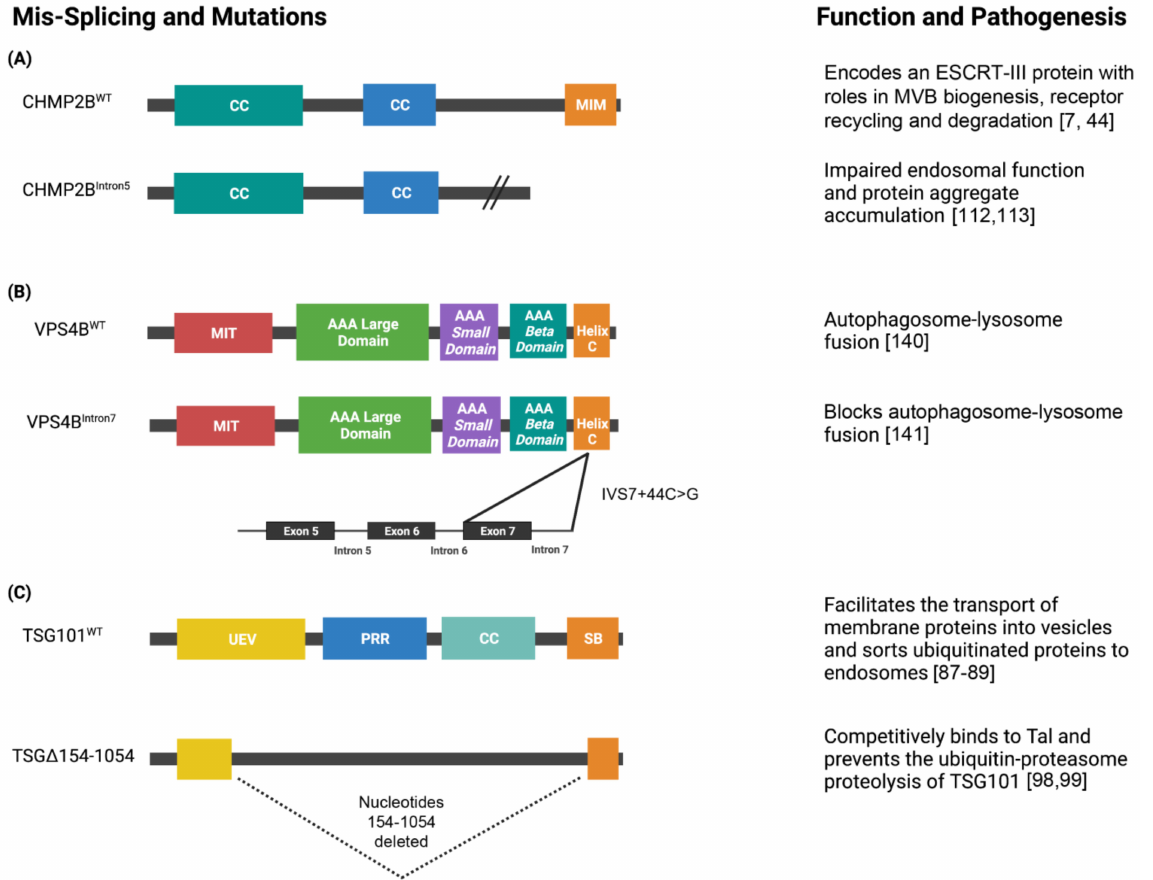
Figure 4. Schematics of the domain architecture of ESCRT proteins and their alternatively spliced isoforms. ( A ) CHMP2B is a 213 amino acid protein that contains two N-terminus coiled-coiled (CC) domains and a MIT-interacting motif (MIM) at its C-terminus. CHMP2B encodes an ESCRT-III protein that is essential for the biogenesis of multivesicular bodies (MVB’s) and sorting ubiquitinated proteins into intralumenal vesicles. The splice site mutation linked to chromosome 13 in CHMP2B produces the isoform CHMP2BIntron5. CHMP2BIntron5 forms a C-terminal truncated protein that lacks the MIM domain. The altered C-terminus impairs endosomal function and causes protein aggregate accumulation, which is a pathogenesis associated with FTLD-U, PSP, and CBD. ( B ) VPS4B is a 444 amino acid protein that contains a microtubule interacting and transport (MIT) domain that serves as an adapter for ESCRT-III proteins, large and small AAA ATPase domains, and a C-terminal helix domain. A mis-splicing event of VPS4B results in a novel donor splice site in intron 7 (IVS7 + 46C >